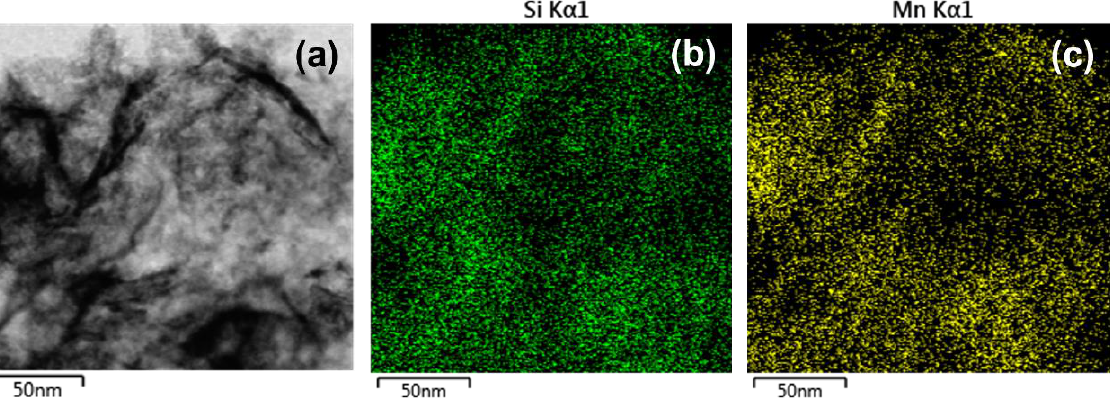
Figure 4. STEM image ( a ) and mapping showing the Si ( b ) and Mn ( c ) distributions along the nanozyme.